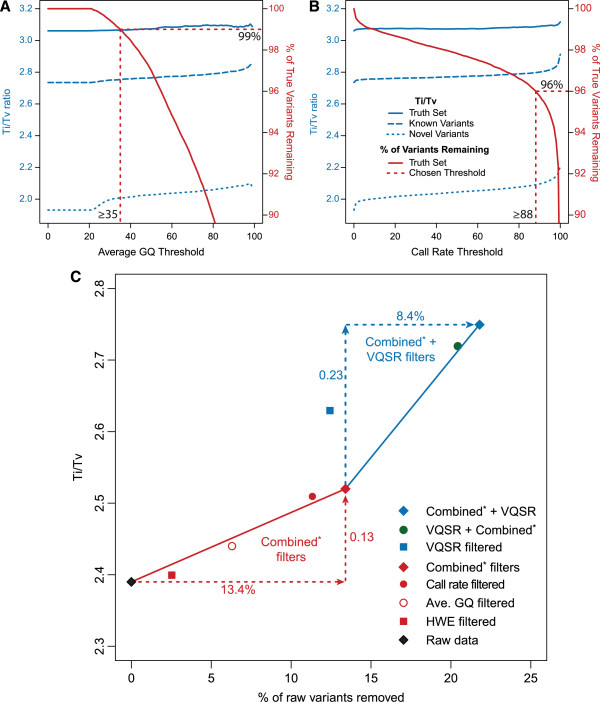
Improved Ti/Tv ratios in WES data using variant filters. Plots illustrate Ti/Tv improvement at different thresholds of A) average GQ and B) call rate. In these plots, Ti/Tv ratios (blue) for novel (dotted line), known (dashed line) and true (solid line) variants are juxtaposed against the drop in sensitivity (red) as the variant filtering thresholds increase. Chosen thresholds are show by the red dashed lines. C) The Ti/Tv improvement after each of the variant filtering steps is summarized. In addition, the result from an alternative filtering order, where VQSR is applied prior to the combined variant filters, is also displayed (green circle). *Combined filters refers to HWE, average GQ and call rate filters applied together.